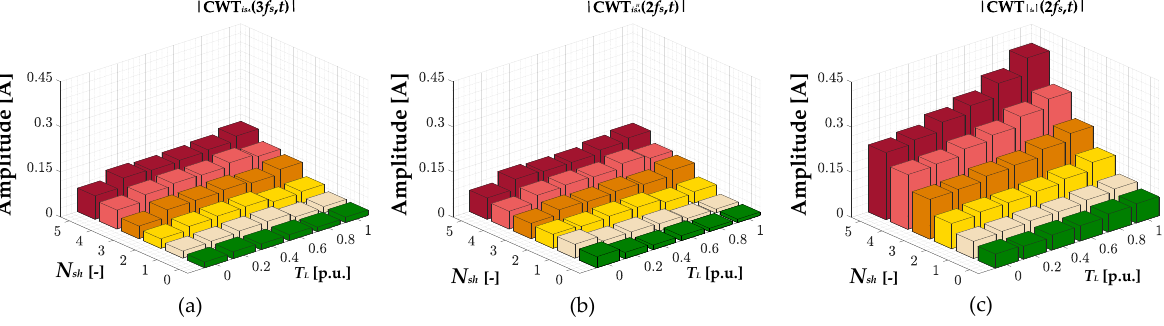
Figure 12. The effect of N sh in the PMSM stator winding and T L level on the amplitude of the extracted symptoms ( a ) |CWT isA (3 f s , t )|, ( b ) |CWT isH A (2 f s , t )| and ( c ) |CWT |isA| (2 f s , t )| ( f s = f sN = 100 Hz).